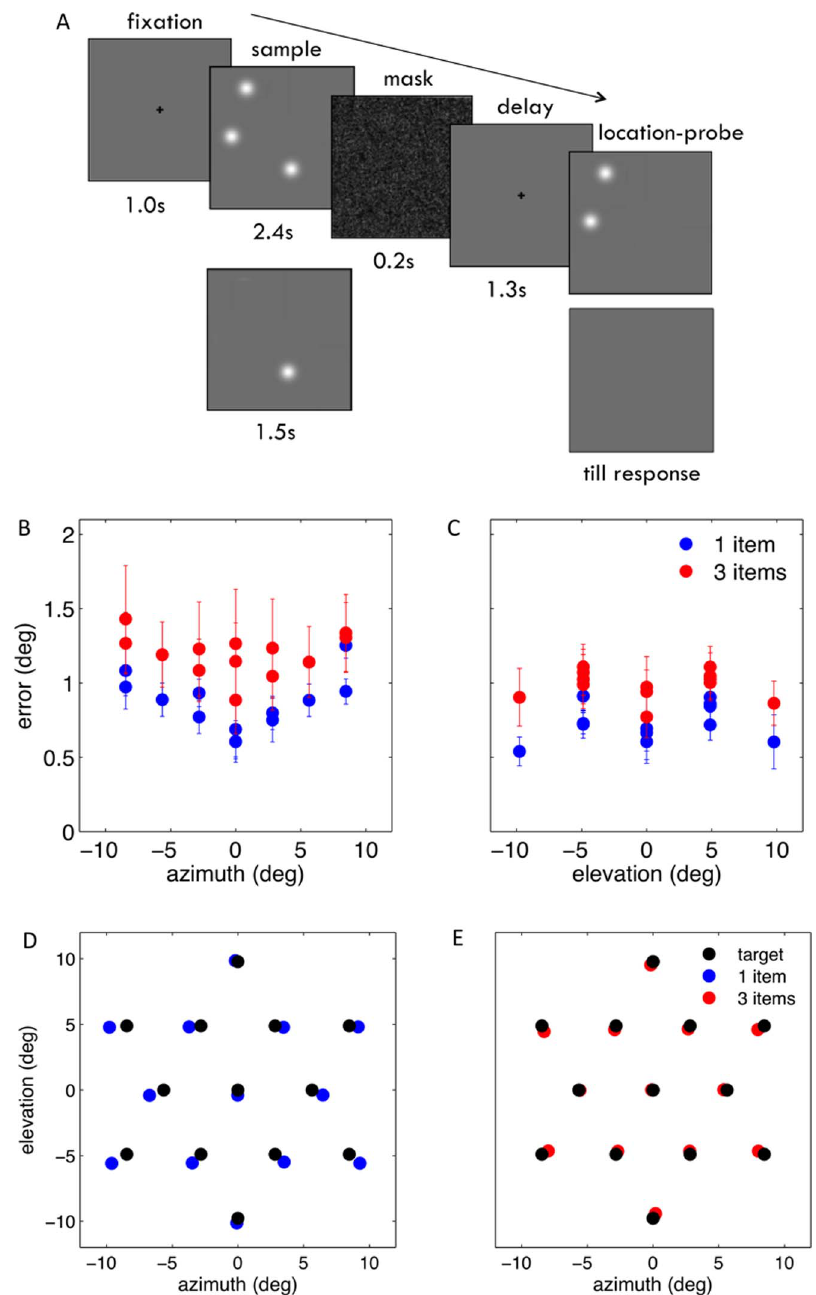
Figure 4. Location-probe diminishes the effects of memory load on recall. (A) Trial structure. When the memory load was three, the target to be recalled was identified by highlighting the location of the two non-target items. When the memory load was one the appearance of the cursor indicated the beginning of the recall period. (B) The error standard deviation is shown as a function of target azimuth, when the memory load is one (in blue) and three (in red), and (C) as a function of target elevation. Along azimuth, the variable error increases monotonically with target eccentricity. Along elevation, however, the variable error shows a peak at eccentricities intermediate between the display center and its boundaries. (D) Recalled targets were systematically displaced outward and downward (in blue) relative to their location in the sample display (in black) when the memory load was one, (E) while they were displaced toward the center of the display when the memory load was three (in red). (see also Figures S1A-C).